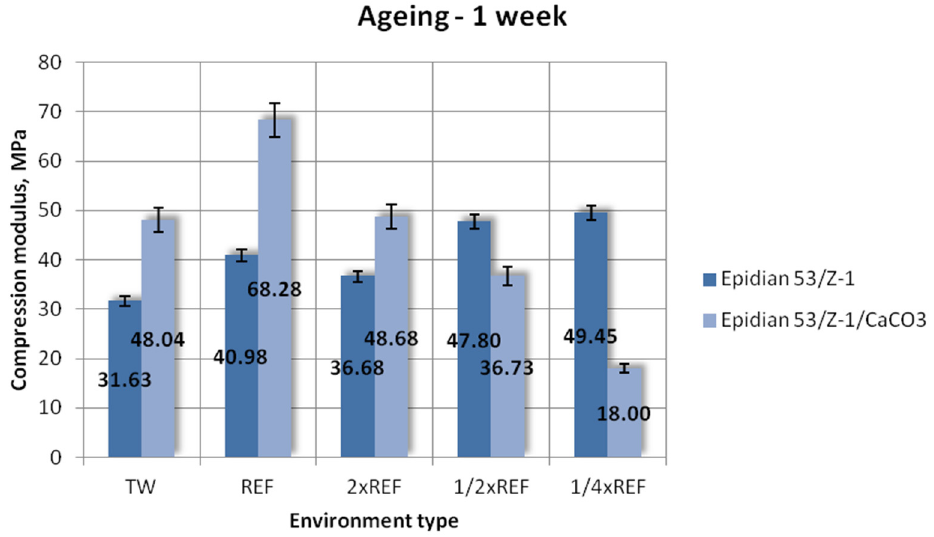
Figure 6. Compression modulus of the unmodified (Epidian 53 / Z-1) and modified (Epidian 53 / Z-1 / CaCO 3 ) epoxy adhesive compounds, aged for 1